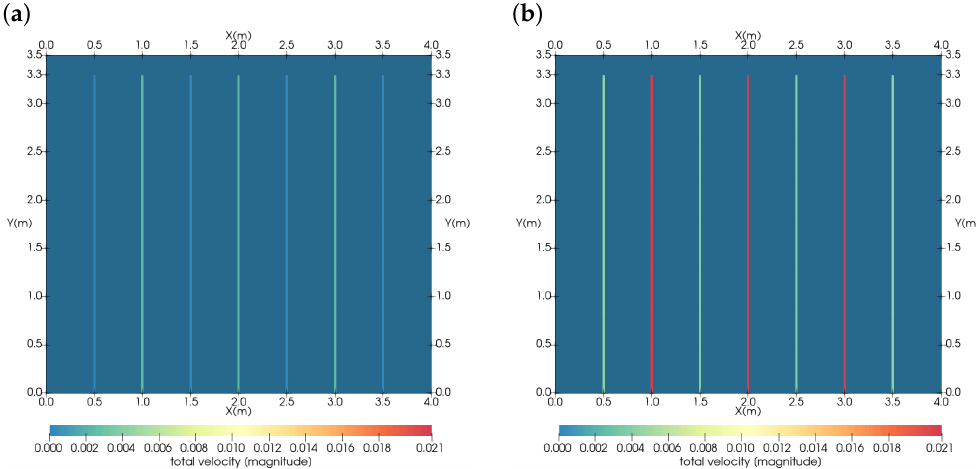
Figure 15. Fracture flow velocity (m/s) in an initially fully water-saturated version of model TUFF2D. ( a ) low precipitation rate, and ( b ) high precipitation